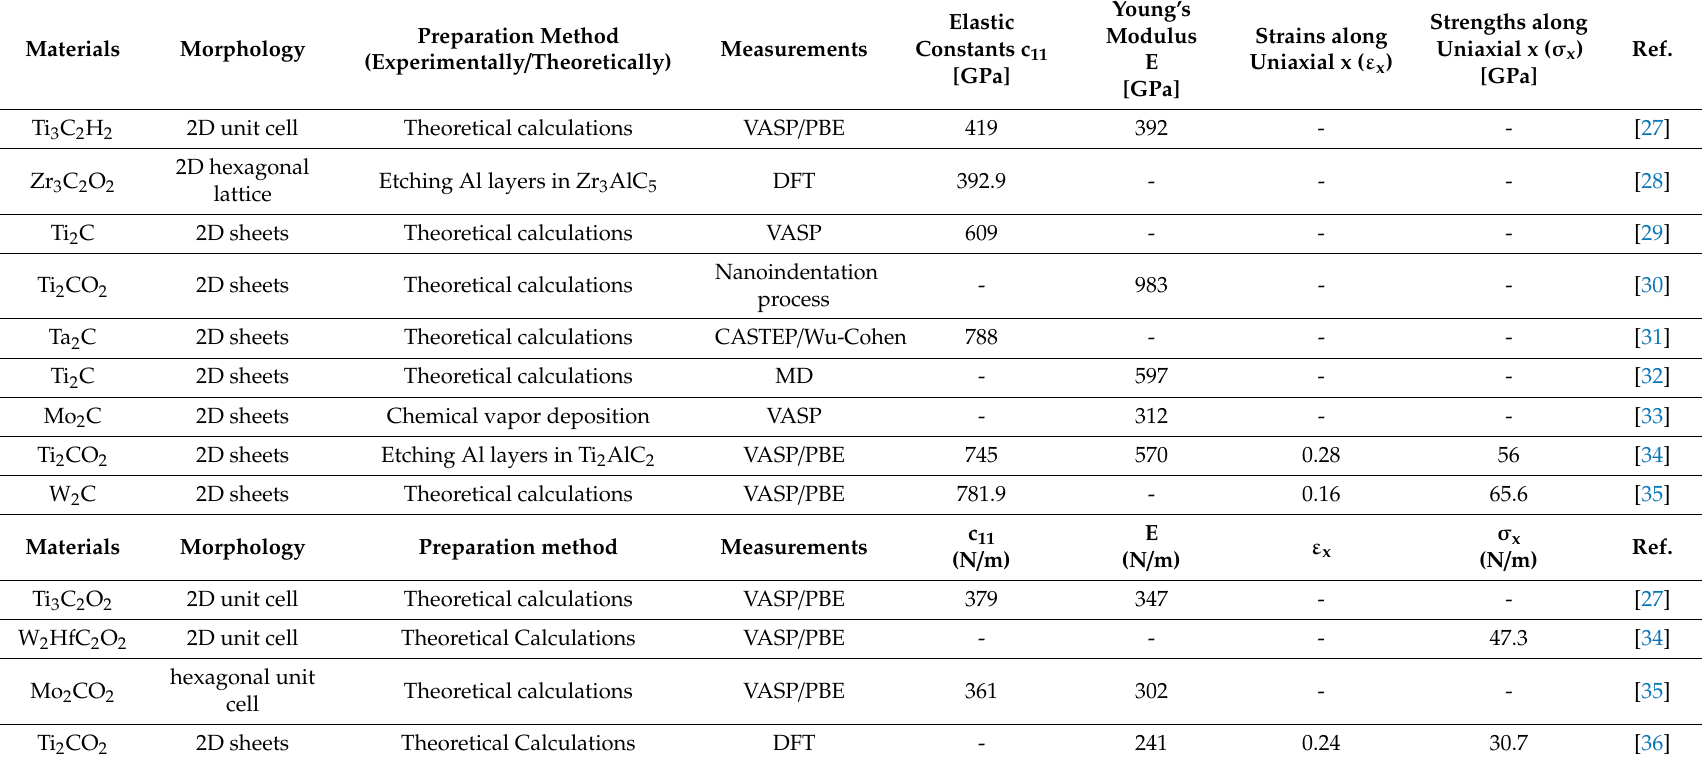
Table 1. The mechanical properties of MXenes with di ff erent